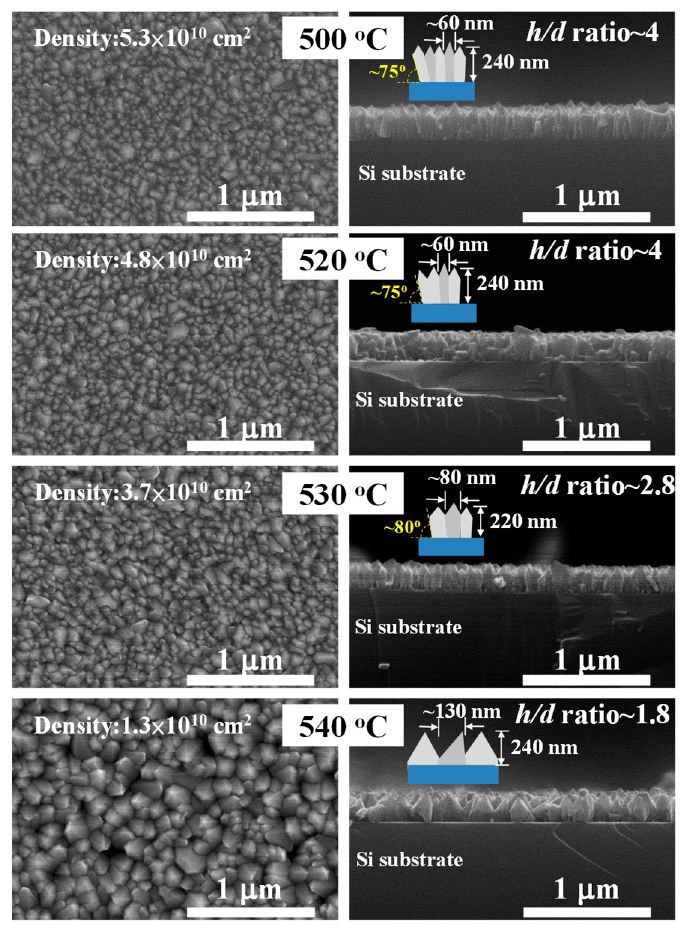
Figure 2. Plane-view and cross-sectional SEM images of InN grown on nitrided Si(111) substrates at different temperatures in the range of 500 to 540 °C.